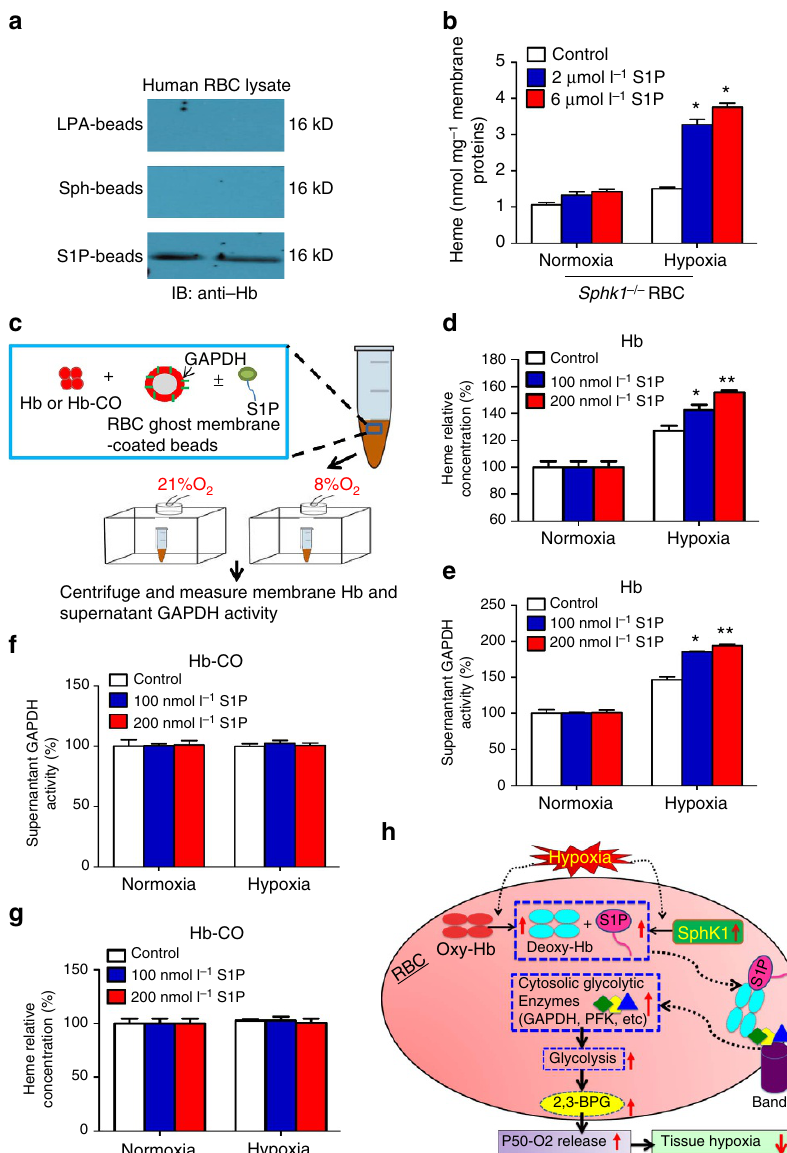
Figure 6 | S1P promotes deoxy-Hb anchoring to the membrane and enhances GPADH release from membrane to cytosol only under hypoxia but not normoxia. ( a ) Pull-down of Hb by lysophosphatic acid, sphingosine and S1P beads from normal human RBC lysates. ( b ) Membrane heme concentrations in isolated Sphk1 (cid:2) / (cid:2) mouse erythrocyte pretreated with DMSO, 2 and 6 m moll (cid:2) 1 S1P in normoxia and hypoxia (4% O 2 ) for 6h. ( c ) Schematic drawing illustrates functional experiments to monitor translocalization of GAPDH from membrane isolated from human erythrocytes. Hb binding to membrane ( d ) and GAPDH release from membrane to the cytosol ( e ) in human erythrocyte membrane ghost treated with Hb and different concentrations of S1P under normoxia and hypoxia. Hb binding to membrane ( f ) and GAPDH release from membrane to the cytosol ( g ) in human erythrocyte membrane ghost treated with Hb-CO and different concentrations of S1P under normoxia and hypoxia. ( h ) Working model: hypoxia-mediated elevation of erythrocyte Sphk1 activity increases the level of S1P, which binds to deoxy-Hb and facilitates binding of deoxy-Hb to membrane and release of GAPDH; increased cytosolic GAPDH accelerates glycolysis and shifts glucose metabolism in favour of 2,3-BPG production, which in turn leads to more O 2 release to counteract tissue hypoxia. Mean ± s.e.m; n ¼ 6 per group, * P o 0.05 versus normoxia, ** P o 0.05 versus 2 m moll (cid:2) 1 or 100nmoll (cid:2) 1 , Student’s t -test and one-way